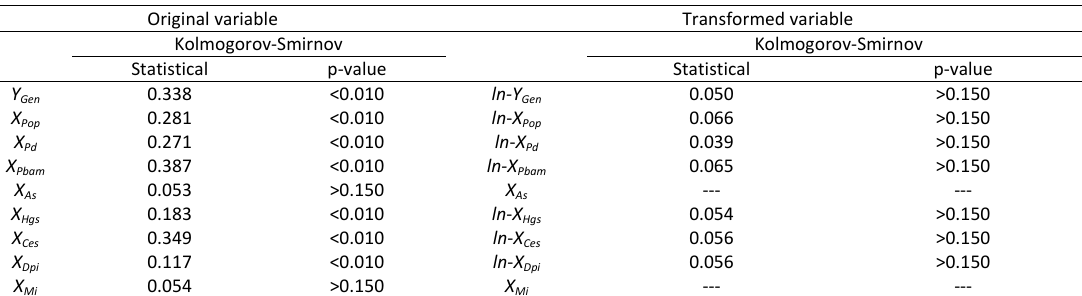
Table 2: Normality test and transformation of variables